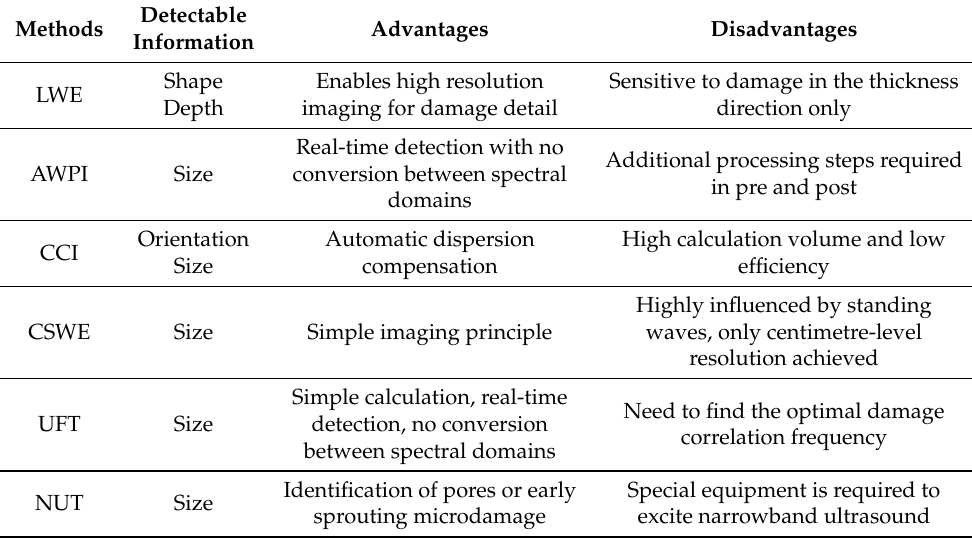
Table 2. Comparison of detection methods based on full wavefield